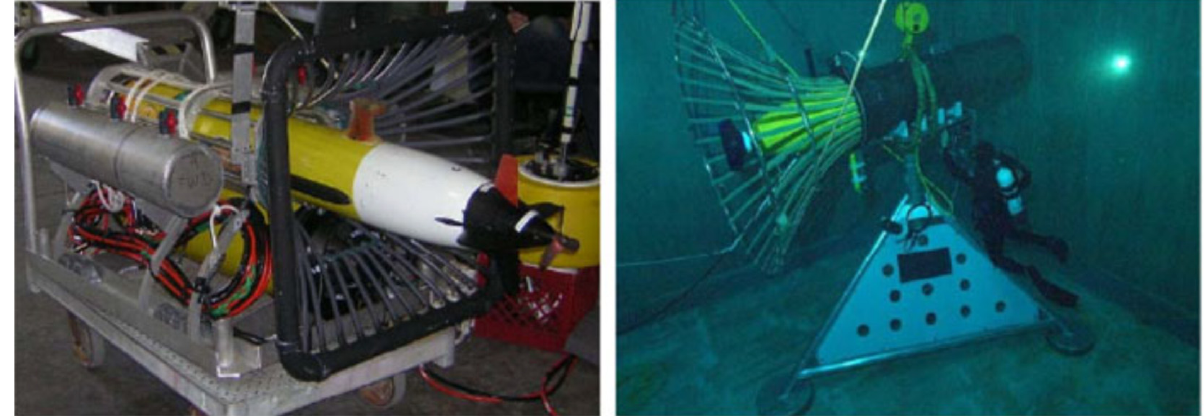
Figure 22. Overview of AUV (left ) and docking station ( right ) [128].